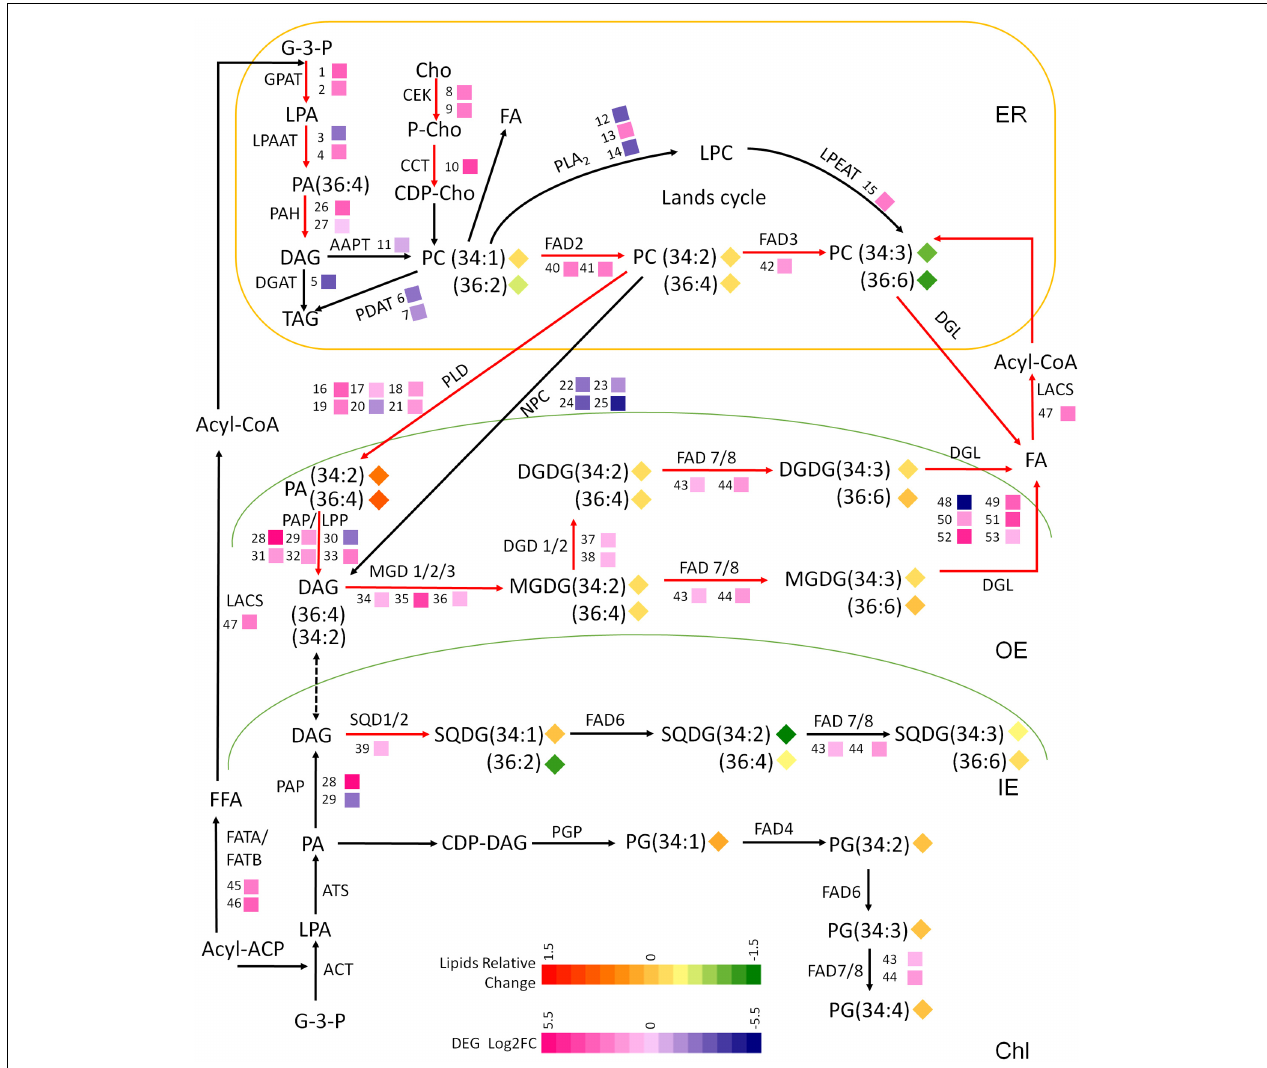
FIGURE 4 | A schematic diagram of gene-metabolite network demonstrates lipid metabolism in maize under low temperature stress. The glycerolipids synthesis pathways were depicted and the involving genes and lipid melatolites were symbolized. The relative change of lipid molecular species [(5 ◦ C mol % –22 ◦ C mol %)/22 ◦ C mol %] and the relative expression levels of selected genes [Log2FC ≥ 1.5 or ≤ –1.5, (5 ◦ C vs. 22 ◦ C)] were marked as heat-map icons. The red arrows represents activated steps by cold. ER, endoplasmic reticulum; OE, outer envelope; IE, inner envelope; Chl, chloroplast. The map is based on (Ohlrogge